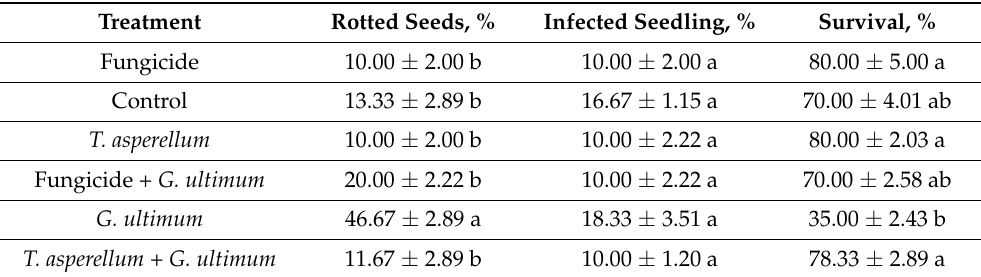
Table 2. Disease assessment of pea damping-off under inoculation with Trichoderma asperellum ZNW and/or G. ultimum NZW. Treatment Rotted Seeds, % Infected Seedling, % Survival, % Fungicide 10.00 ± 2.00 b Control 13.33 ± 2.89